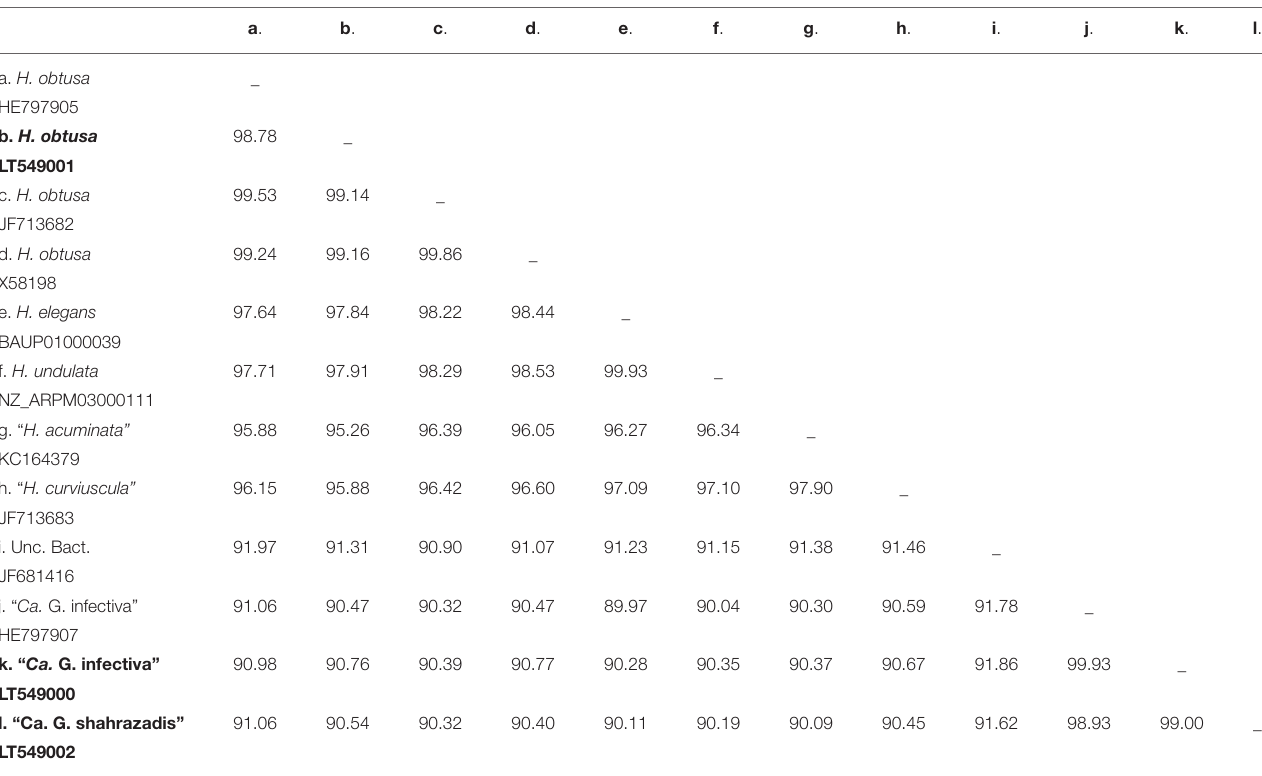
TABLE 2 | Identity values among Holospora -like bacteria 16S rDNA